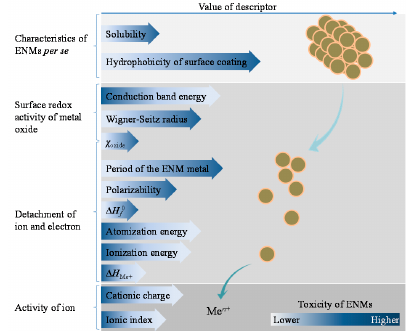
Figure 1. Generalization of the role of different factors in affecting the toxicity of metallic ENMs based on the state-of-the-art of nano-(Q)SARs and read-across models for ENMs. Me n + represents the released ions from ENMs; ∆ H f 0 is the enthalpy of formation of metal oxide nanocluster representing a fragment of the surface; ∆ H Me+ is the enthalpy of formation of a gaseous cation having the same oxidation state as that in the metal oxide structure; and χ cation represents the electronegativity of the metal